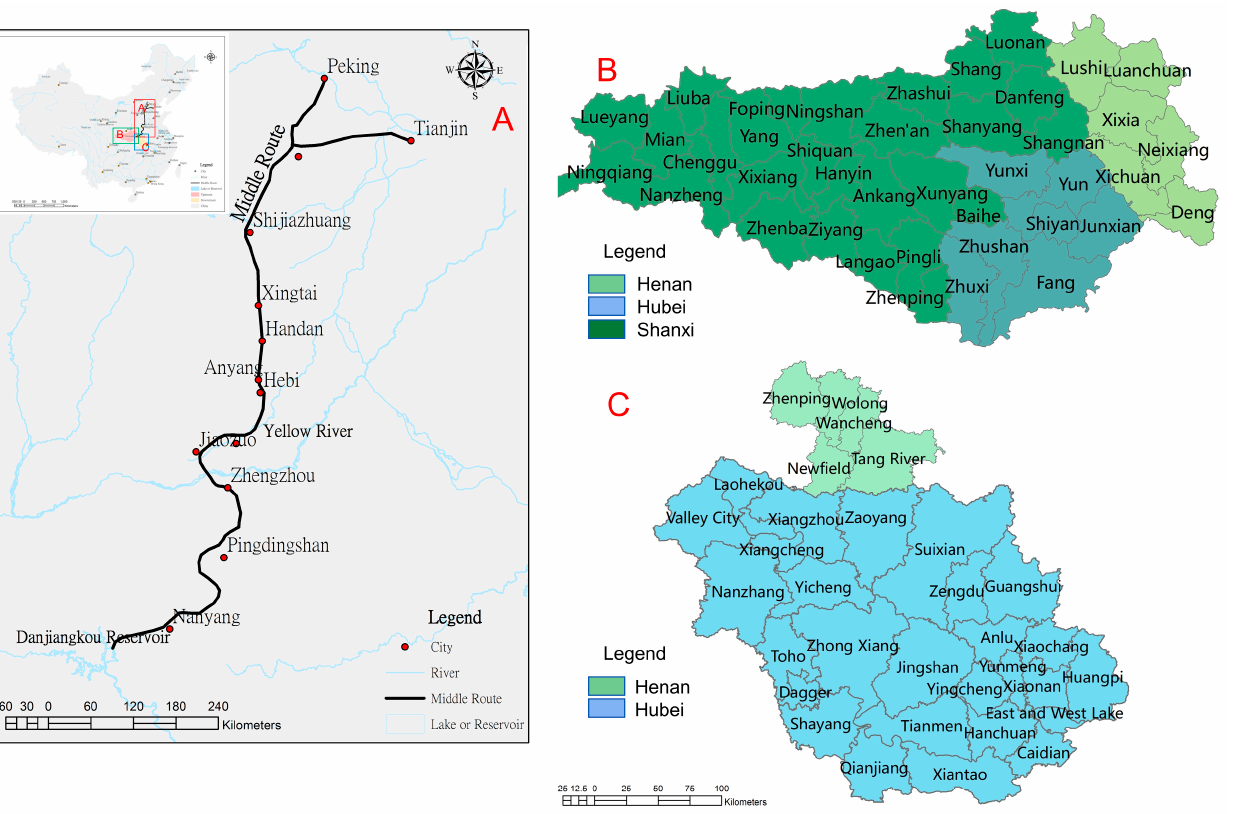
Figure 1. Range of influence of SNWTP-MR. (( A ) is the whole process of water transfer in the SNWTP-MR; ( B ) is the scope of the water source area for water transfer; ( C ) is the downstream of the water source area.)